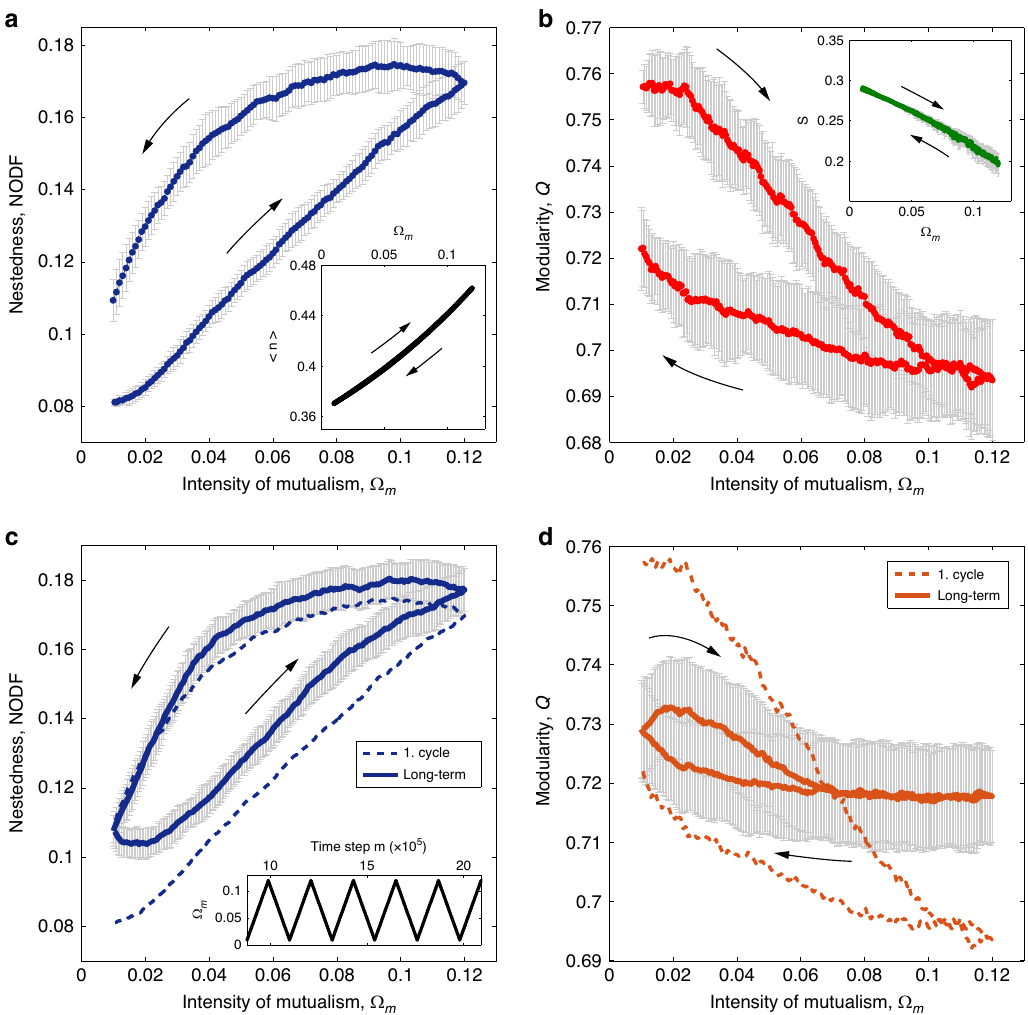
Fig. 4 Asymmetric structural adaptation. a , b The nestedness and modularity measures show hysteretical trajectories with the intensity of mutualism Ω m , demonstrating asymmetric adaptation in opposite directions. A very slow change rate ( Δ Ω m = 10 − 6 per time interval) is used during the reciprocation of Ω m so that the system is guaranteed to be always at quasi-steady-states. In contrast, the same population 〈 n 〉 (inset of upper panel) and stability S (inset of lower panel) are recovered on the altered network structure when Ω m is restored. c , d Long-term response to cyclic change. The asymptotic behavior of the nestedness settles to a stable closed hysteresis loop. In contrast, the variation of modularity becomes narrowly constraint and more symmetric along both directions. Data are obtained from 50 simulation runs and presented as mean values± SD.